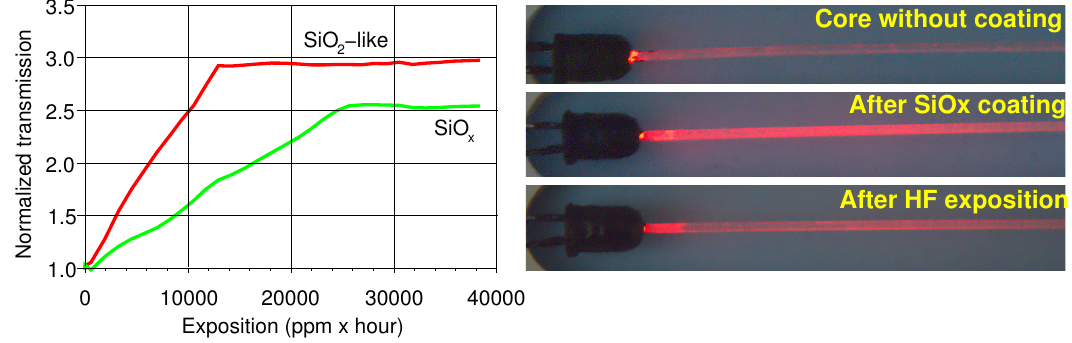
Figure 10. ( Left ) Fiber transmittance change with exposure to HF vapors. ( Right ) Example pictures of the same fiber in three different stages: ( top ) the fiber after cladding removal, but before the SiO deposition; ( middle ) the fiber after the SiO x after exposure to the HF